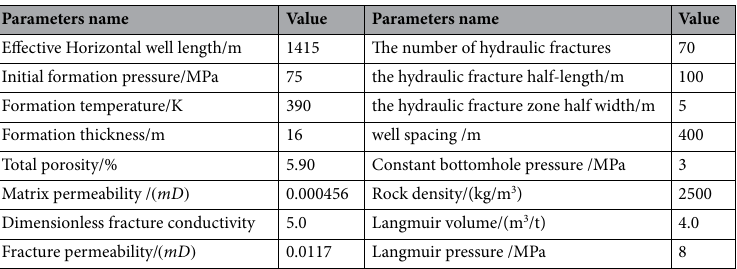
Table 2. Well testing interpretation parameters of the numerical model based on the IHS RTA 45 .